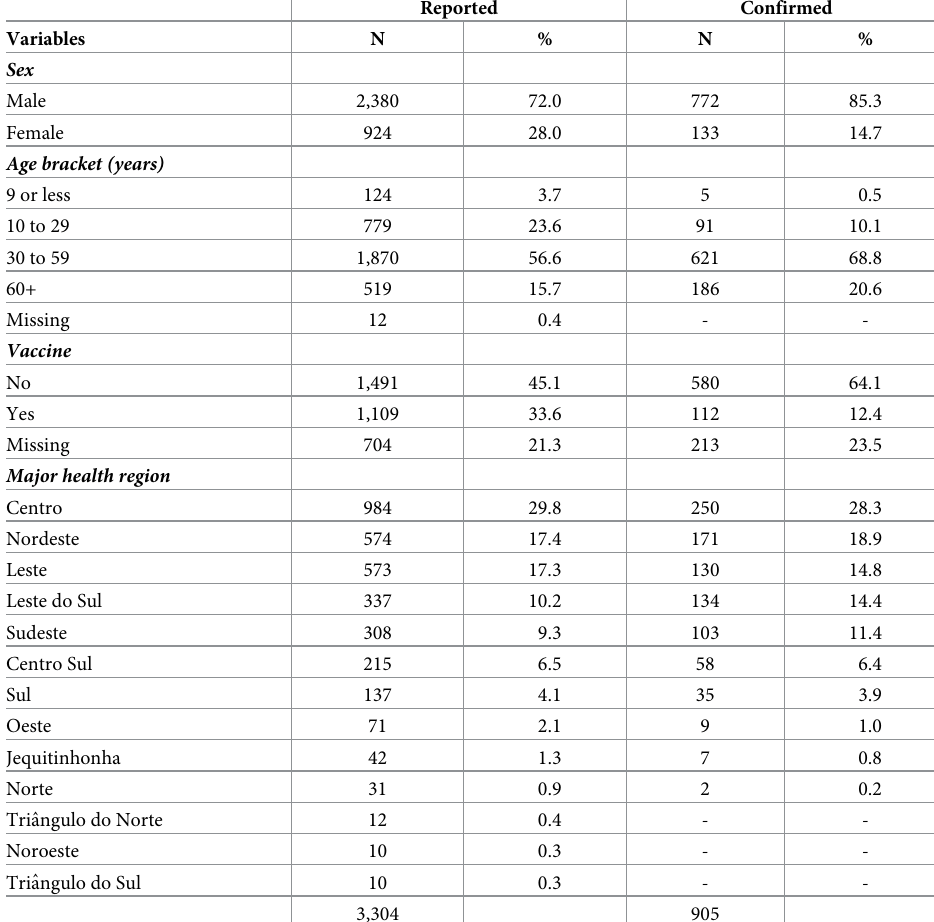
Table 2. Likely and confirmed cases of yellow fever according to selected variables, Minas Gerais, Brazil, 2016 to 2018.